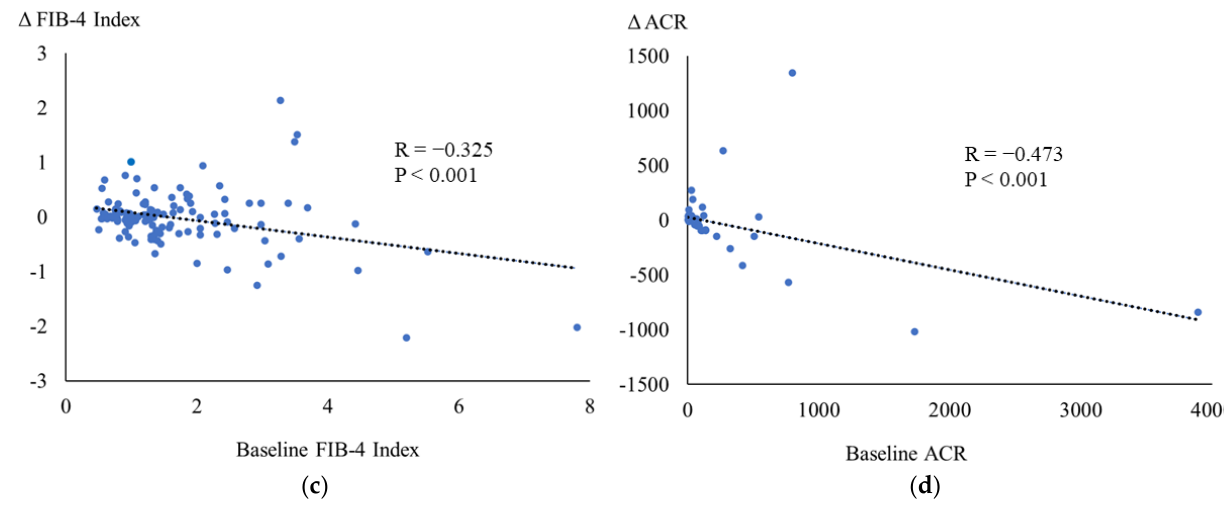
Figure 1. The results of Pearson’s simple correlations among the parameters during 12 months after the start of dulaglutide. ( a ) The correlation between the changes in HSI and the baseline HSI. ( b ) The correlation between the changes in NFS and baseline NFS. ( c ) The correlation between the changes in FIB-4 index and the baseline FIB-4 index. ( d ) The correlation between the changes in ACR and the baseline ACR. ACR, albumin-to-creatinine ratio; HSI, hepatic steatosis index; NFS, NAFLD fibrosis score. The correlations between the changes in metabolic parameters during 12-month dulaglutide